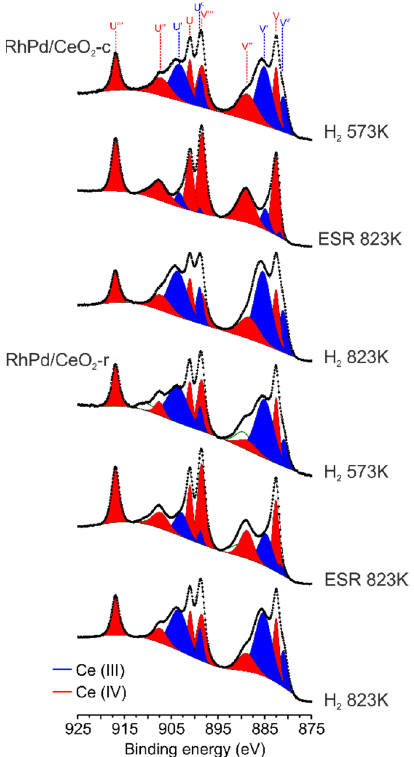
Figure 6. NAP-XPS spectra of Ce 3d corresponding to Rh 0.5 Pd 0.5 / CeO 2 -c and Rh 0.5 Pd 0.5 / CeO 2 -r catalysts under different gaseous atmospheres using 1150 eV of photon energy. Reprinted with permission from Ref [69], copyright 2019, American Chemical Society.